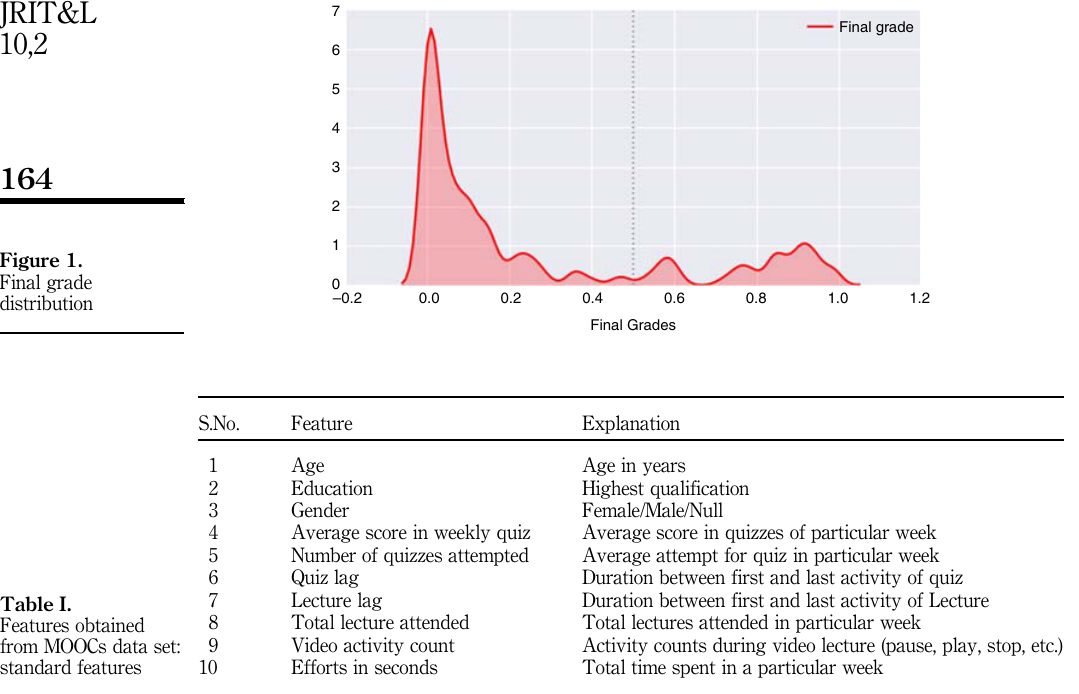
Figure 1. Final grade distribution